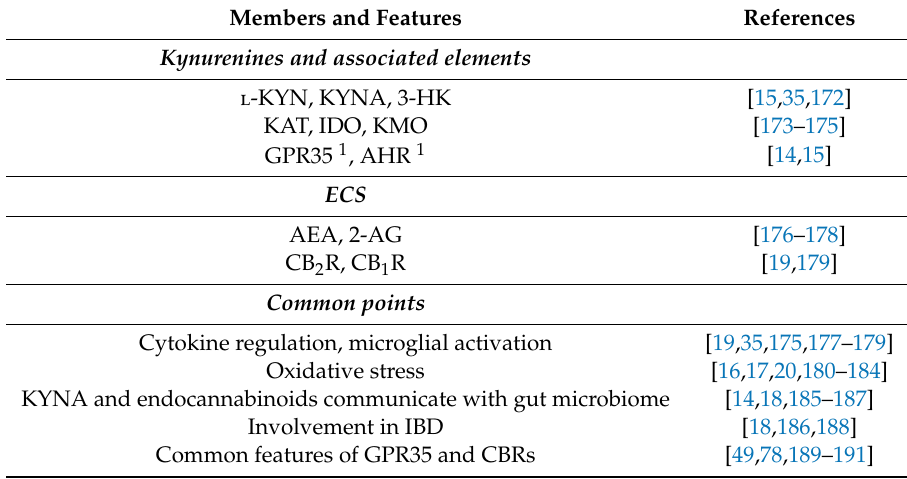
Table 4. Kynurenines and associated elements (enzymes, receptors) and members of the ECS that participate in the inflammatory mechanism of schizophrenia. The table also highlights the common points between the two systems relevant to this